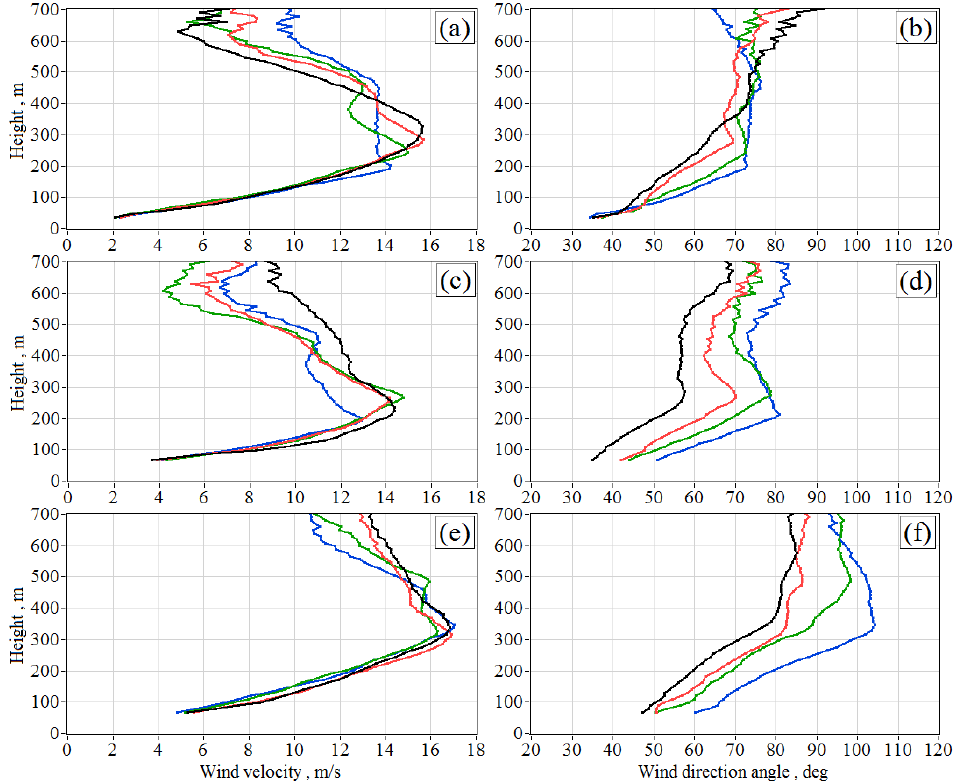
Figure 2. Vertical profiles of wind velocity ( a , c , e ) and wind direction angle ( b , d , f ) retrieved from measurements by the StreamLine lidar on 20–21 July ( a , b ), 21–22 July ( c , d ), and 22–23 July ( e , f ) of 2016 every hour at 23:00 (black curves), 00:00 (red curves), 01:00 (green curves), and 02:00 Local Time (LT) (blue curves). Each profile is obtained from one-minute